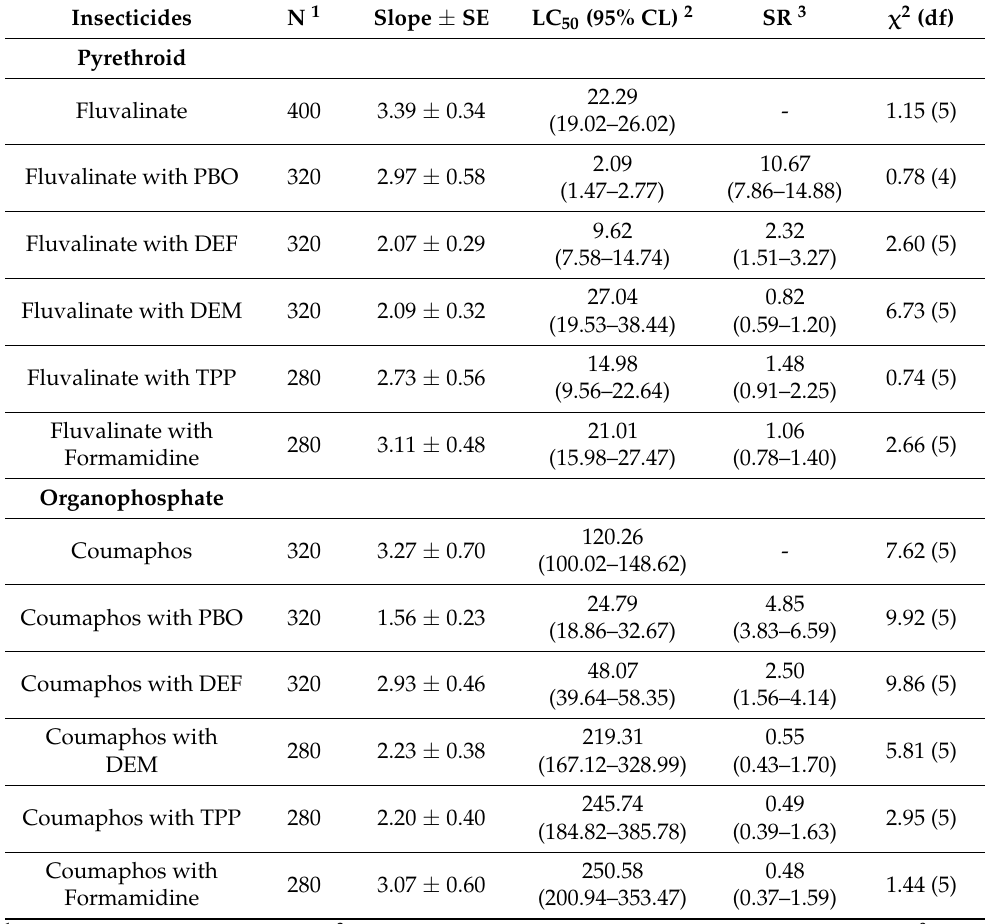
Table 1. The toxicity of the pyrethroid fluvalinate and the organophosphate coumaphos with and without synergists to the small hive